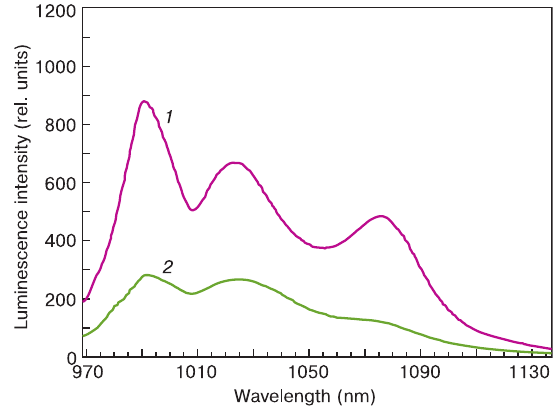
Yb Na )Ga O and ( 2 ) (Ca 0.9 0.05 0.05 2 4